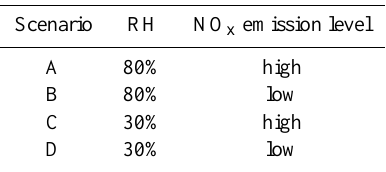
Table 4. Scenario definitions with respect to relative humidity (RH) and NO x emission